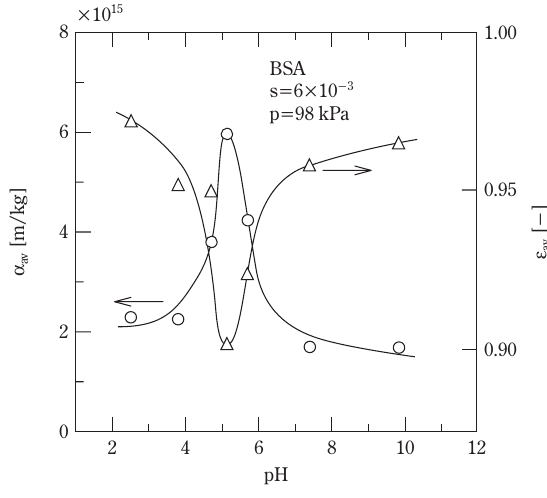
Fig. 15 Effect of pH on average specific filtration resistance and average porosity of filter cake formed in microfiltration of titanium dioxide suspensions.